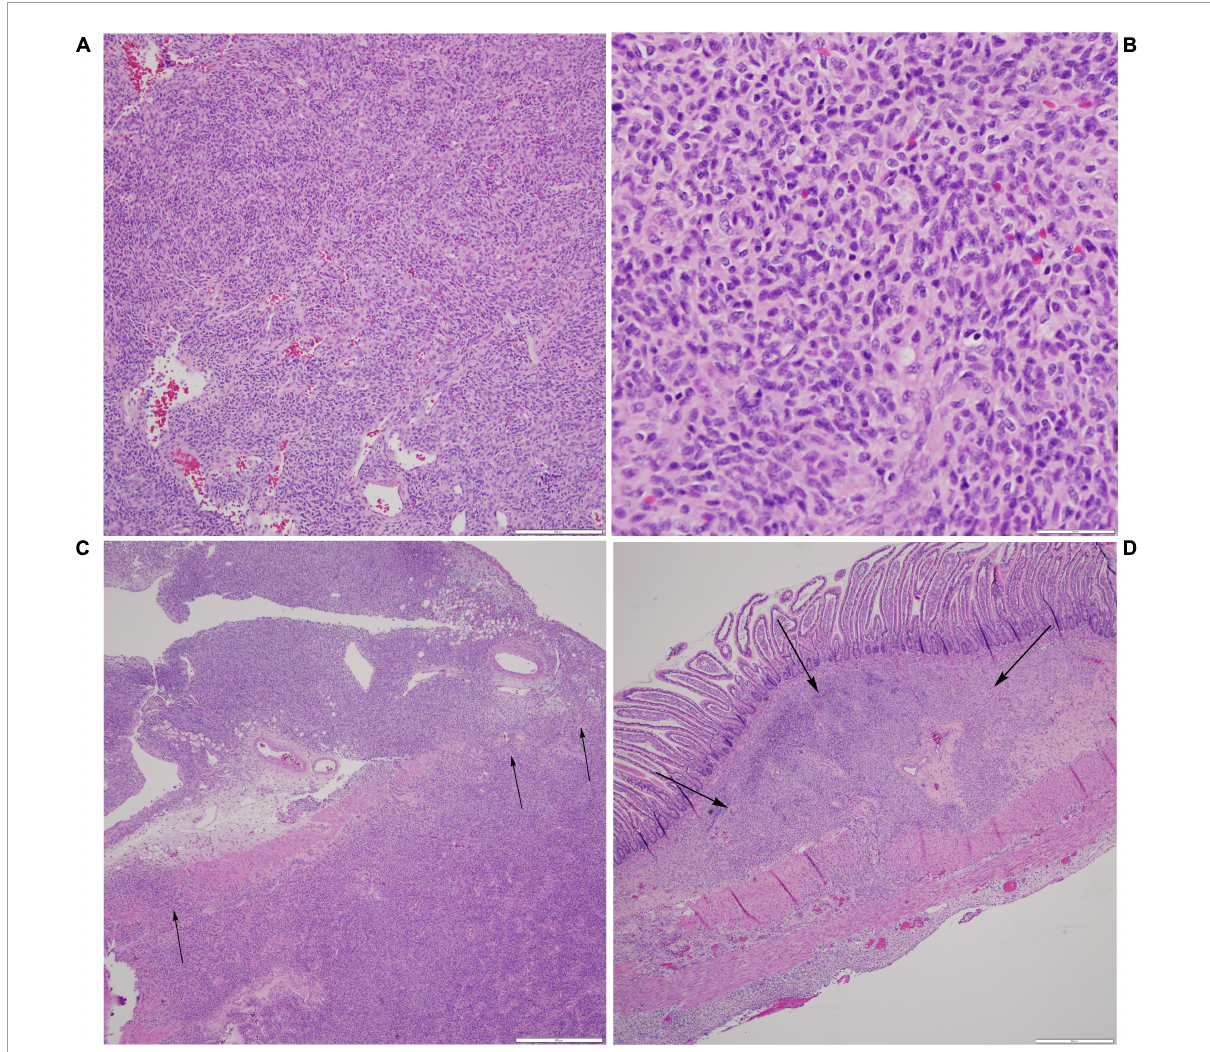
FIGURE3 Histological examination of neoplasm. (A) Prominent vasculature is identified within some areas of the spindle cell neoplasm, with several vessels demonstrating a staghorn-like appearance (H&E, scale bar is 200 microns). (B) At higher power, the neoplastic cells are monomorphic, ovoid to spindled, with a moderate amount of cytoplasm and coarse chromatin, and scattered apoptotic bodies are noted (H&E, scale bar is 50 microns). (C) At the site of perforation, the neoplastic cells are seen infiltrating through the muscularis propria and into the serosa and surrounding fibroadipose tissue (H&E, scale bar is 500 microns). (D) These nests of neoplastic cells are away from the main site of perforation and are identified as percolating through the submucosa (H&E, scale bar is 500